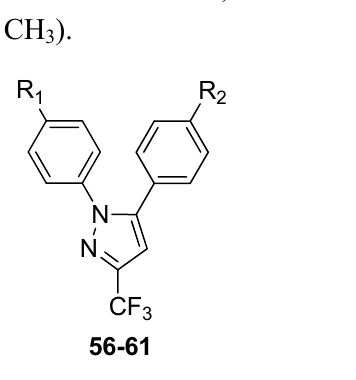
Figure 32. Hybrid COX-2/NO donor compounds obtained by Knaus et al . ( 62a , R